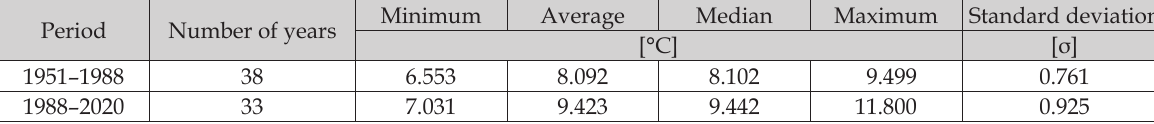
Table 1. Basic statistics of the annual air temperature in Poznań in the two sub-periods. Period